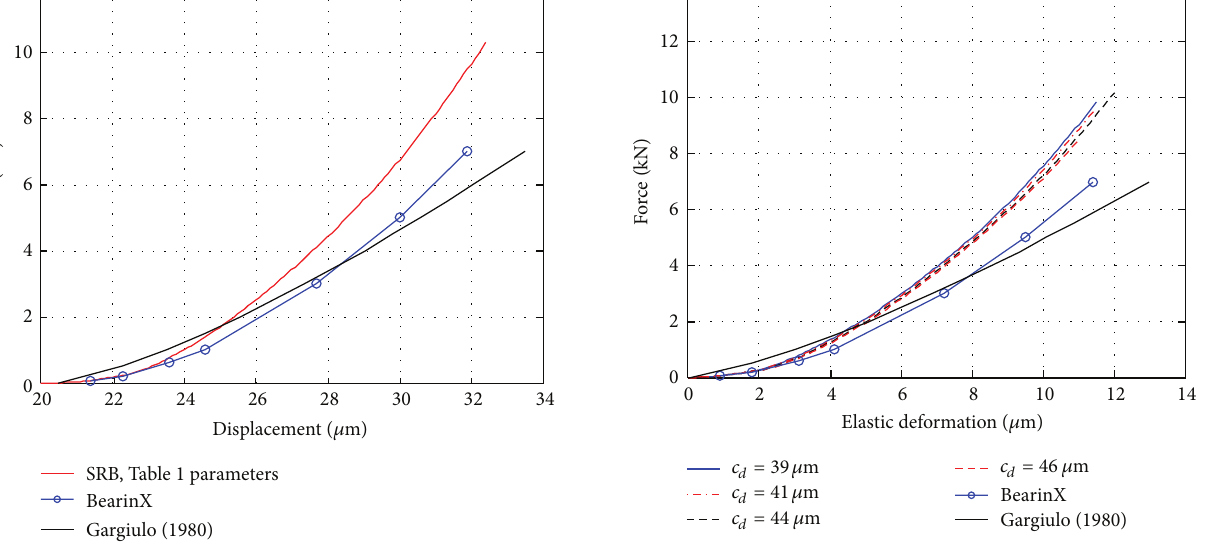
Figure 7: Radial force with respect to displacement.